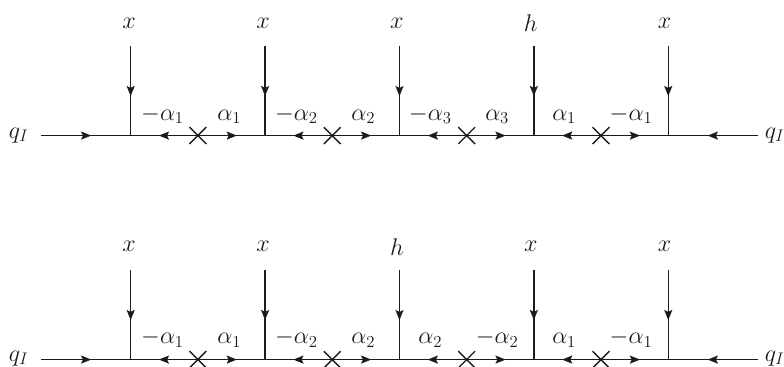
Figure 11 . An example of a diagram (upper) in the case of I = J and only one di(cid:11)erent 45 or 210 (cid:12)eld with global U(1) charge x , which cannot be protected. If the upper diagram is present, then the lower, more symmetric one can be constructed, using a subset of the mediators.